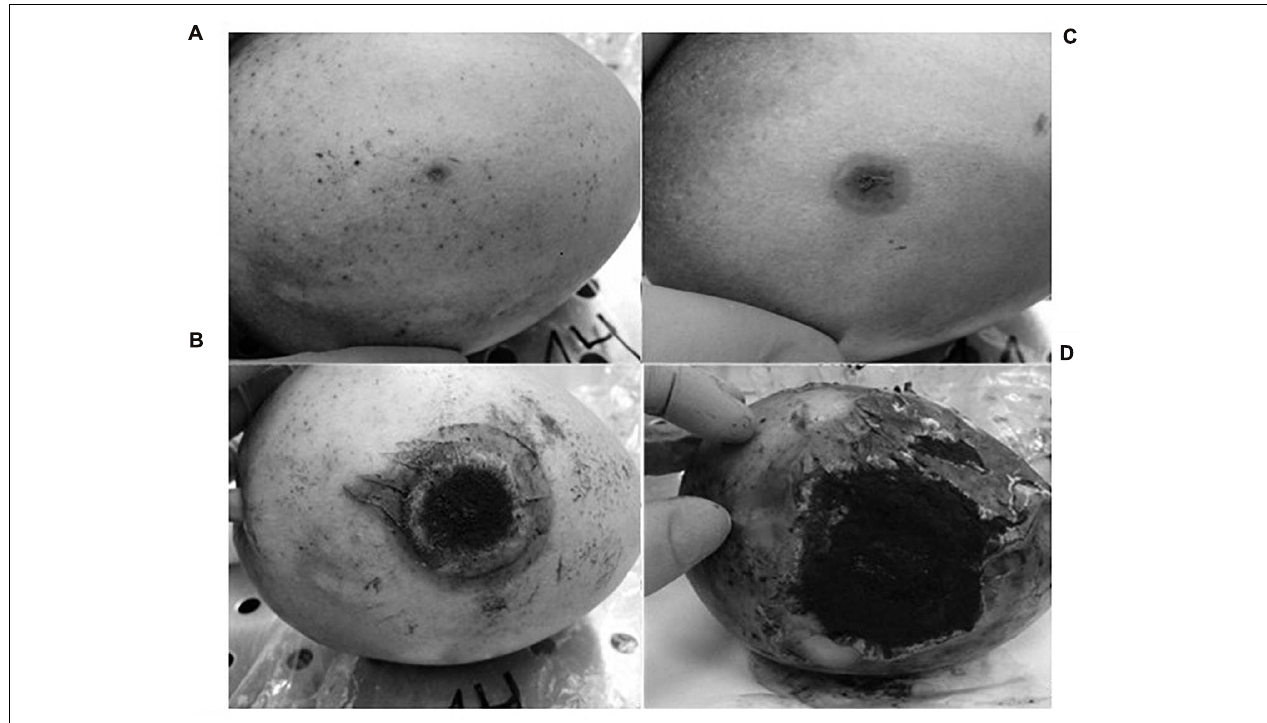
FIGURE 2 | Evolution of the injuries developed by A. niger in mango fruit: (A) 2 days post-infection (p.i.), (B) 4 days (p.i.), (C) 8 days (p.i.), and (D) 14 days (p.i.).